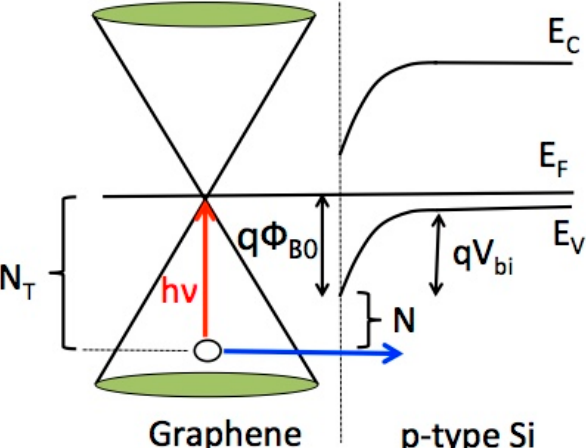
Figure 2. Band diagram of a graphene / silicon Schottky junction: E F is the metal Fermi level, E V (E C ) is the silicon valence (conduction) band, q Φ B is the Schottky barrier and qV bi is the built-in potential. N T and N are the total number of states of excited holes and hole having a certain probability to be emitted into silicon.